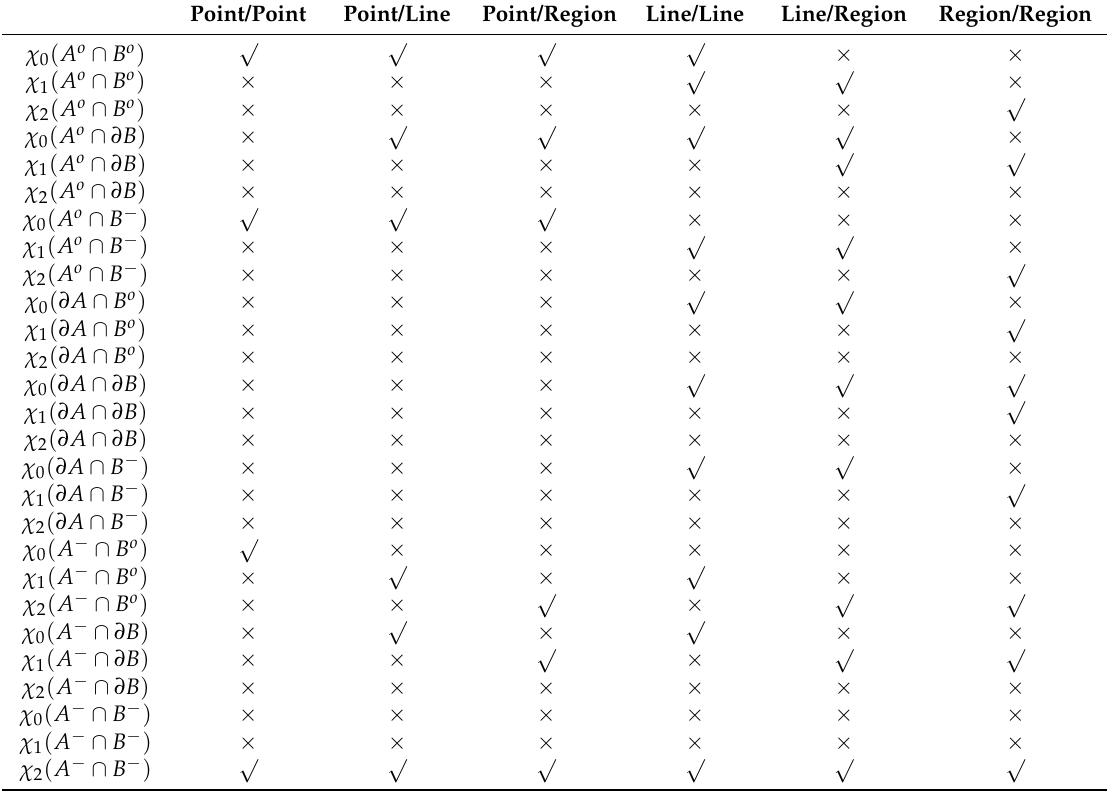
Table 1. Possible tuples for six groups of topological